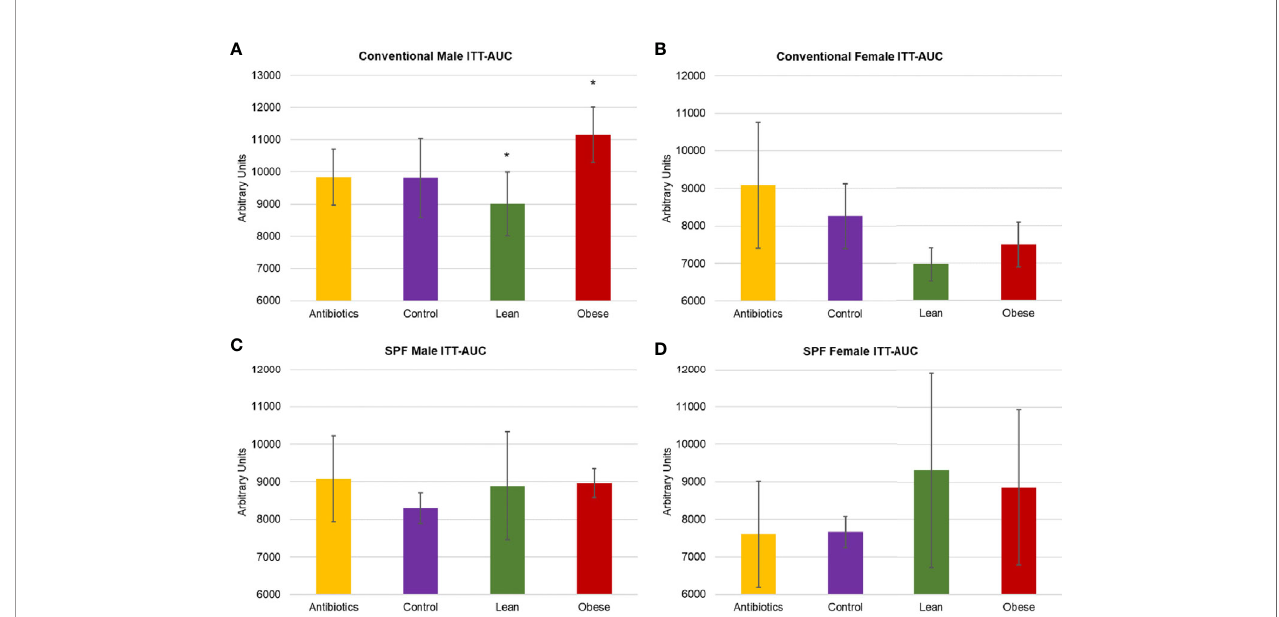
FIGURE 3 | Metabolic characterization of conventionally housed and SPF mice that received microbiota from obese donor Ob1, microbiota from lean donor Ln1, antibiotics alone, and negative control. (A, C) Male and (B, D) female area under curve (AUC) of insulin tolerance test (ITT) for conventional and speci fi c-pathogen- free (SPF) housing, respectively. Values are mean ± standard deviation (n = 2 – 5 mice); * P < 0.05 between recipients of microbiota from Ob1 and